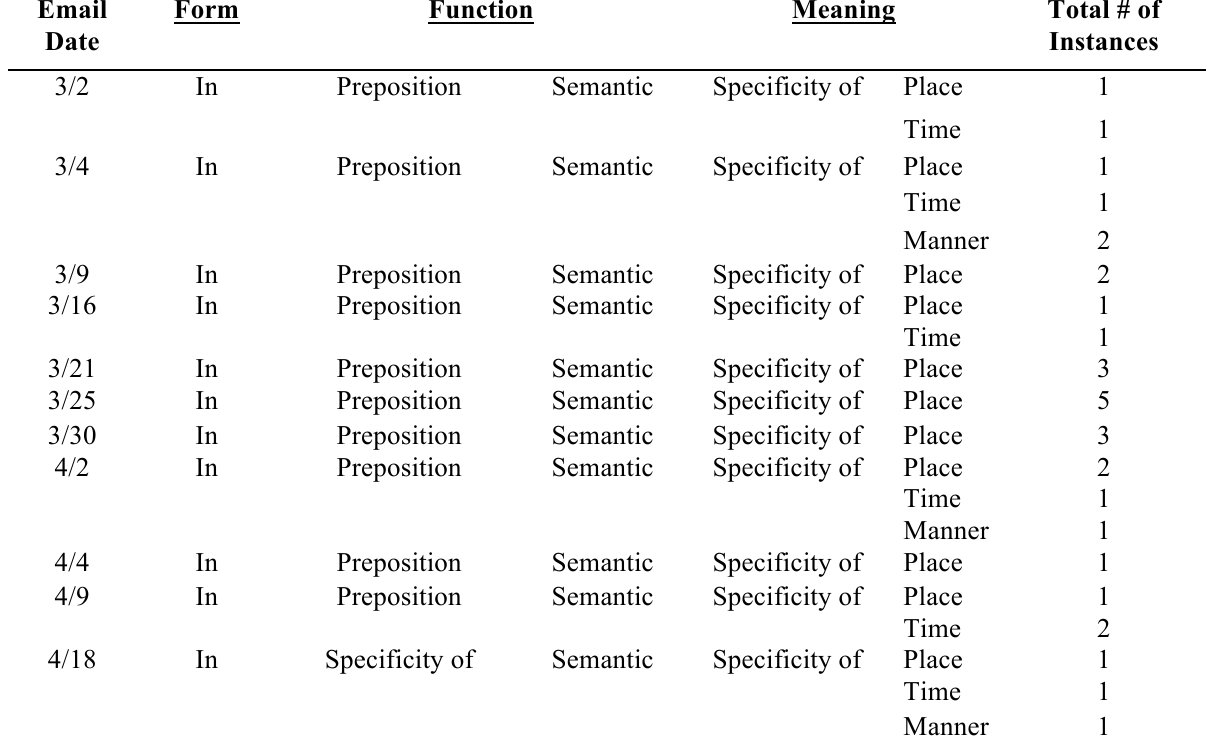
Form-function analysis: Belinda “in”